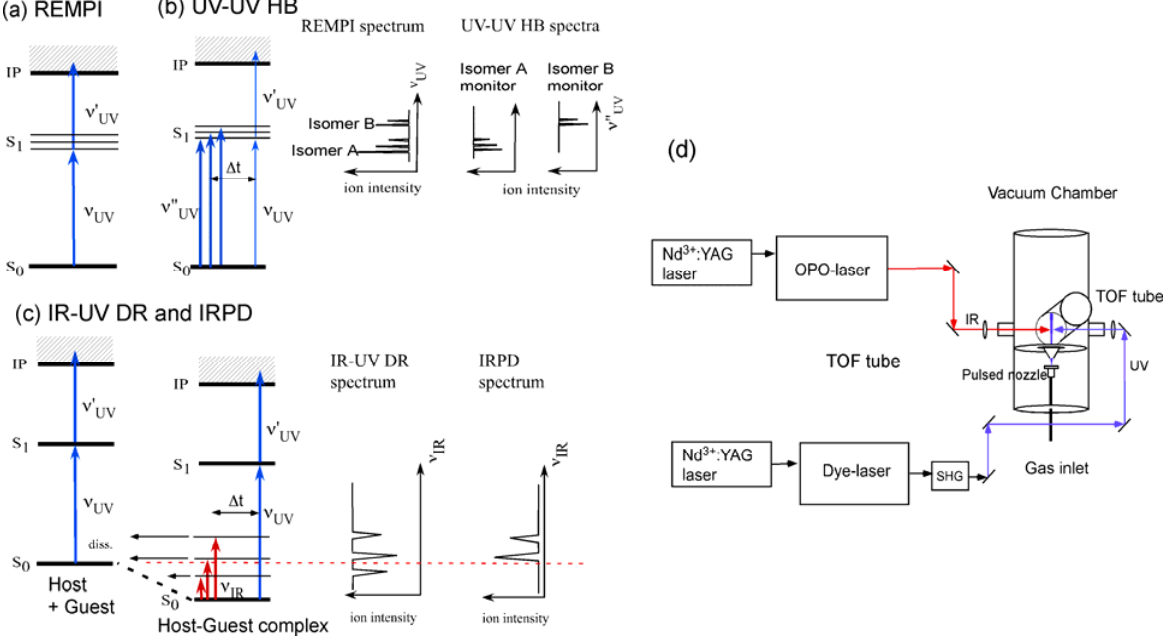
Figure 2. (a)-(c) Several laser spectroscopic methods with the ion signal detection. (d) Experimental setup for the supersonic beam and IR-UV DR